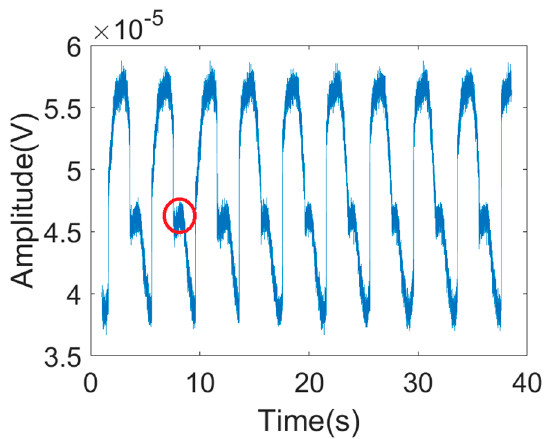
Figure 14. The output with a directional antenna.